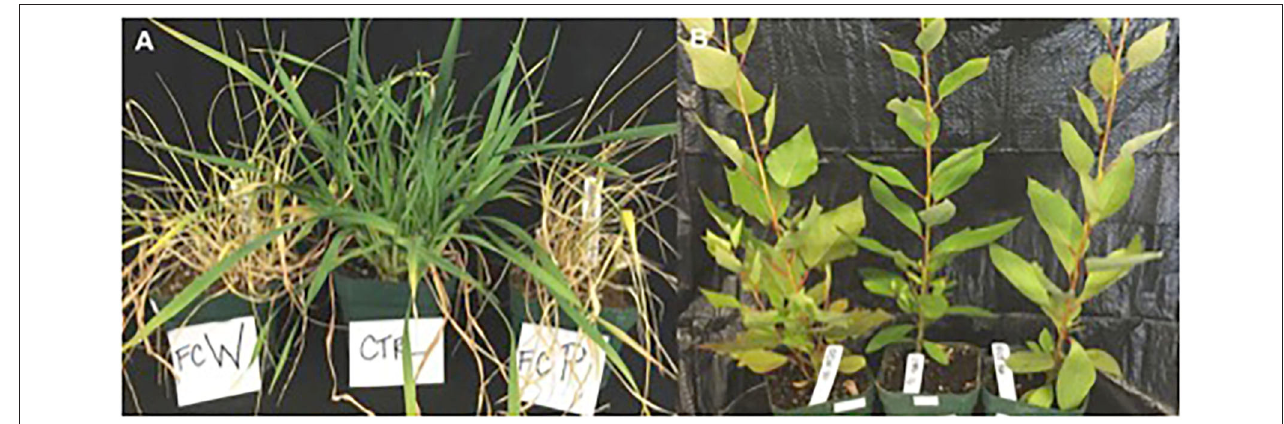
FIGURE 1 | Fusarium culmorum isolates caused disease in wheat (A) but not in poplars (B) . Wheat and poplars were inoculated with an isolate of F. culmorum from wheat (FCW) and from P. trichocarpa (FCP), or with sterile water for the control (CTRL).